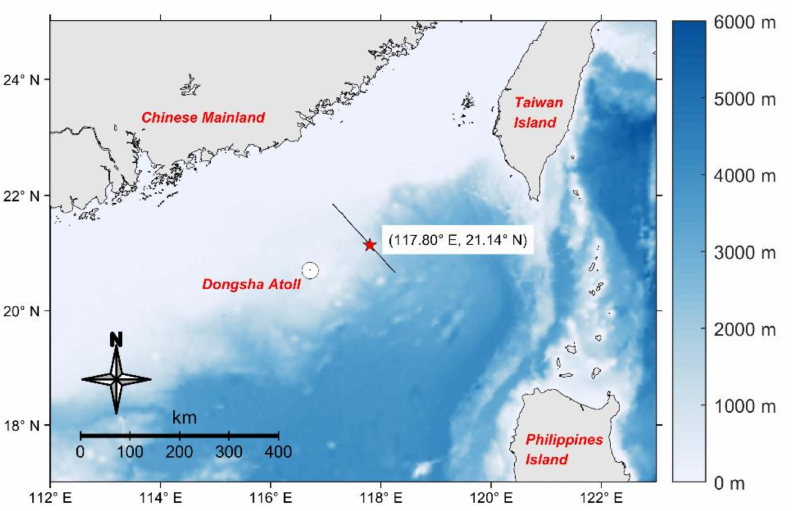
Figure 1. The topography in the South China Sea. The vessel’s track between 18:00 UTC on 21 May and 08:00 UTC on 22 May is located within the black line area. The red pentagram gives the location where the internal solitary wave (ISW) was captured at 00:00 UTC on 22 May